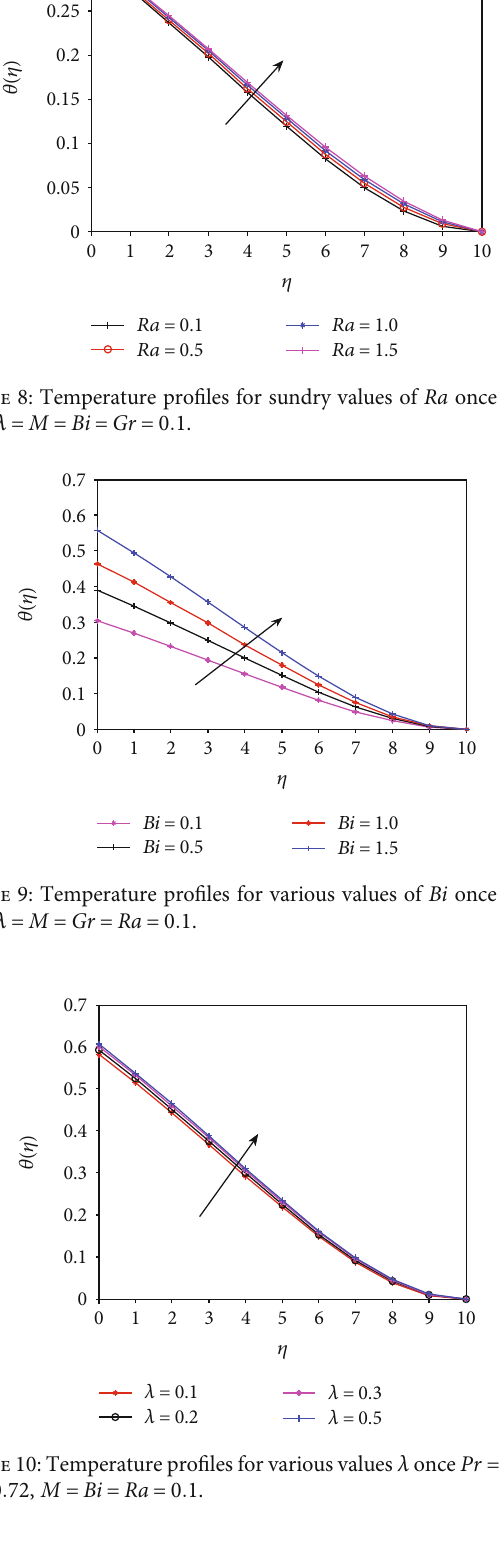
𝜆 = 0.1 𝜆 = 0.2 Figure 10: Temperature pro fi les for various values λ once Pr = 0 : 72 , Gr = 0 : 72 , M = Bi = Ra = 0 : 1